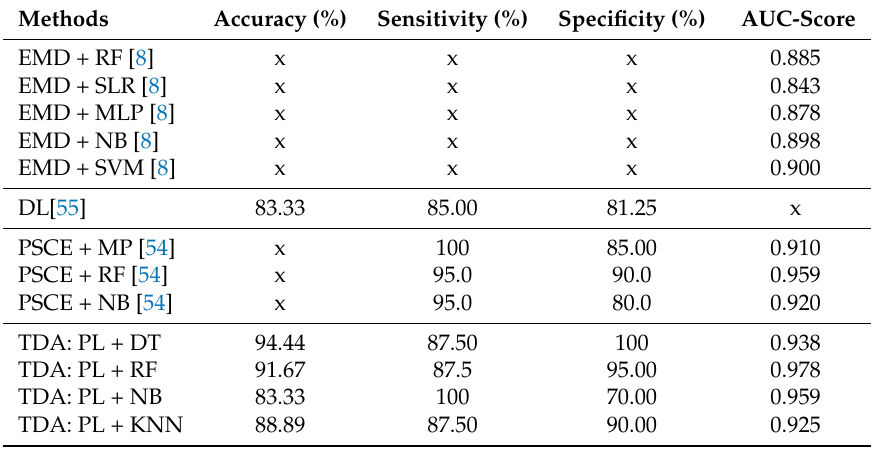
Table 7. Comparisons of AUC and LOO-CV Results for classification of HC and HD groups.